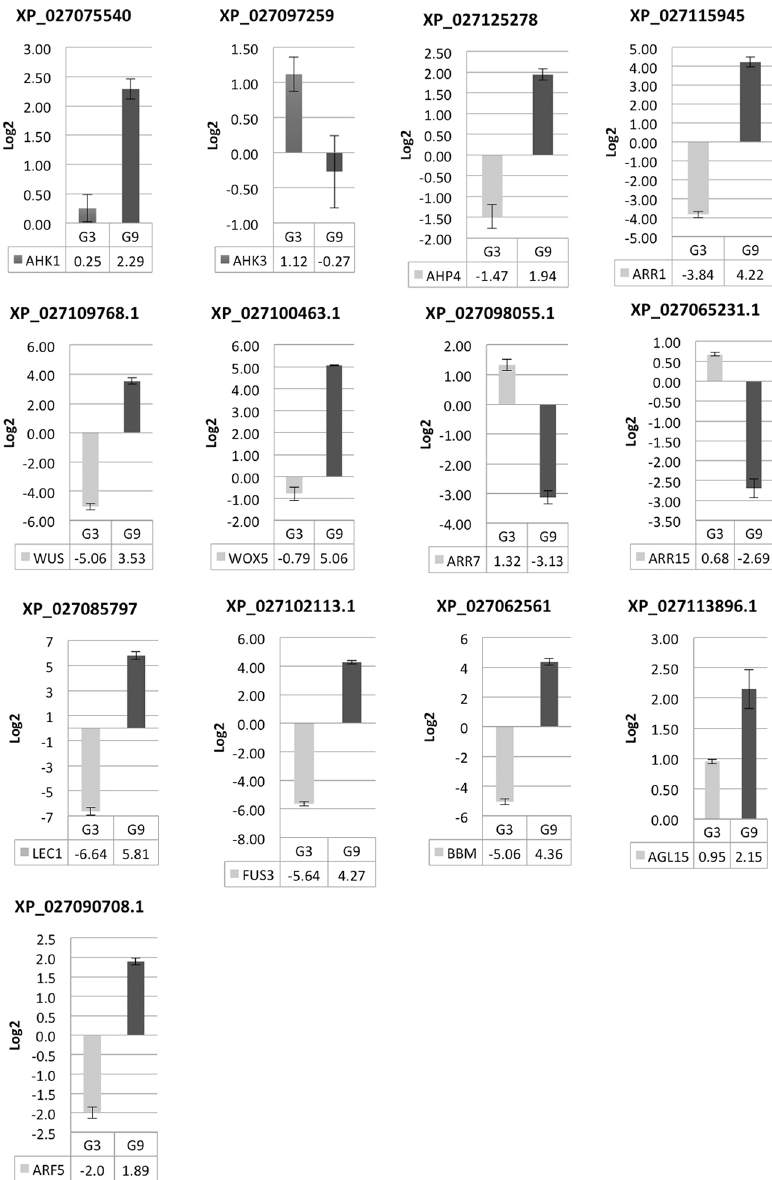
Figure 4. Gene transcript relative expression (Log2) during SEs maturation in C. arabica . Relative expression of genes , AHK1, AHK3, AHP4, ARR1, ARR7, ARR15, WUSCHEL, WOX5, ARF5, LEC1, FUS3, BBM and AGL15. Genes were normalized with, Actine, RP29 and 24S . Each qPCR was conducted with three independent biological replicates. M3, SE-M3; MS medium supplemented with 0.2 mg/L BAP, 0.1 mg/L kinetin, 1% glucose, 3.0 g/L gelrite (− 0.49 MPa), pH 5.8, M9, SE-M9; MS medium supplemented with 0.2 mg/L BAP, 0.1 mg/L Kinetin, 1% glucose, 9.0 g/L gelrite (− 1.47